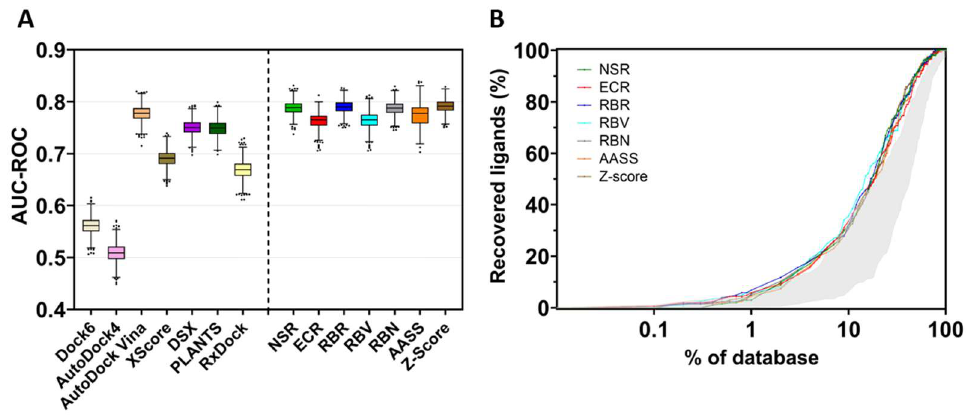
Figure 6. Screening performance of docking programs and consensus strategies. ( A ) area under the curve of the receiver operating characteristics (AUC-ROC). The box plot represents the area obtained for all docking programs and the consensus strategies (NSR: normalized score ratio; ECR: exponential consensus ranking; RBR: rank-by-rank; RBV: rank-by-vote; RBN: rank-by-number: AASS: auto-scaled score; and Z-score). The horizontal line inside the box represents the median value of the distribution, and dots are considered outliers. The mean and the standard deviation were estimated with the bootstrap method (1000 samples). ( B ) Semi-logarithmic representation of EP for docking and consensus strategies. The grey area encompasses the results of the individual docking programs, showing the worst and the best performance. Colored lines represent the performance of the consensus strategies at a given percentage of the database.